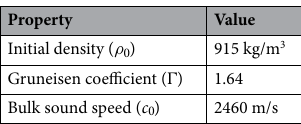
Table 1. Material properties of